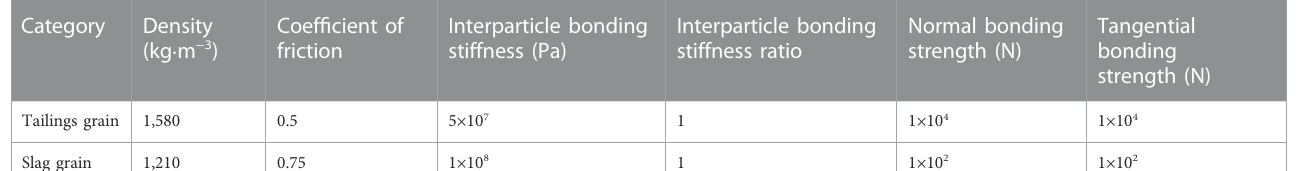
TABLE 4 Fundamental and mechanical parameters of the simulated TSM specimens.